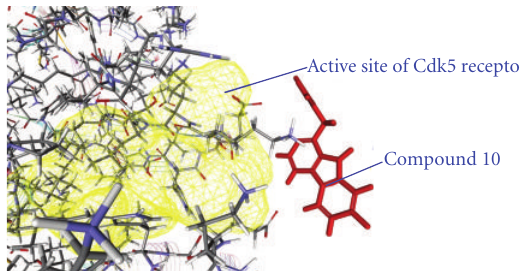
Figure 10: The docked conformation of compound 10 with the receptor CDK5/p25 (PDB: 3O0G). Compound 10 is indicated by red color while the most active site of the CDK5 receptor is shown with yellow color.